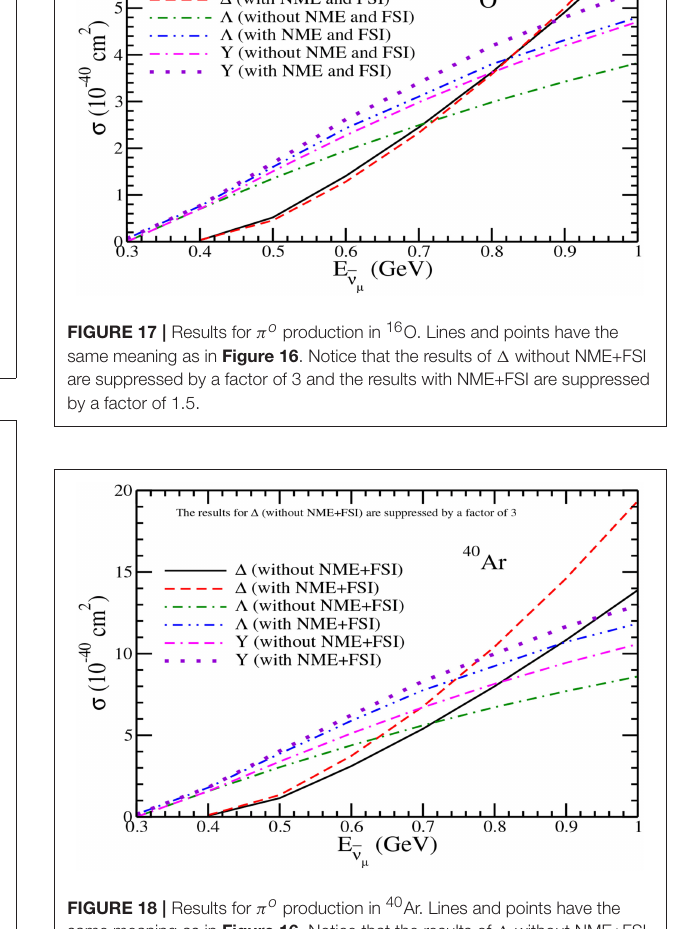
FIGURE 18 | Results for π o production in 40 Ar. Lines and points have the same meaning as in Figure 16 . Notice that the results of 1 without NME+FSI are suppressed by a factor of